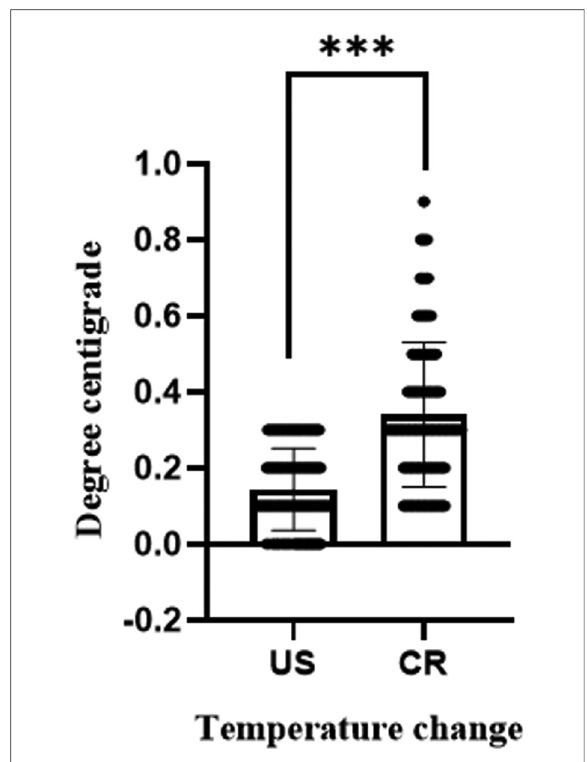
FIGURE 3 Comparison of temperature change between US and CR (*** P <